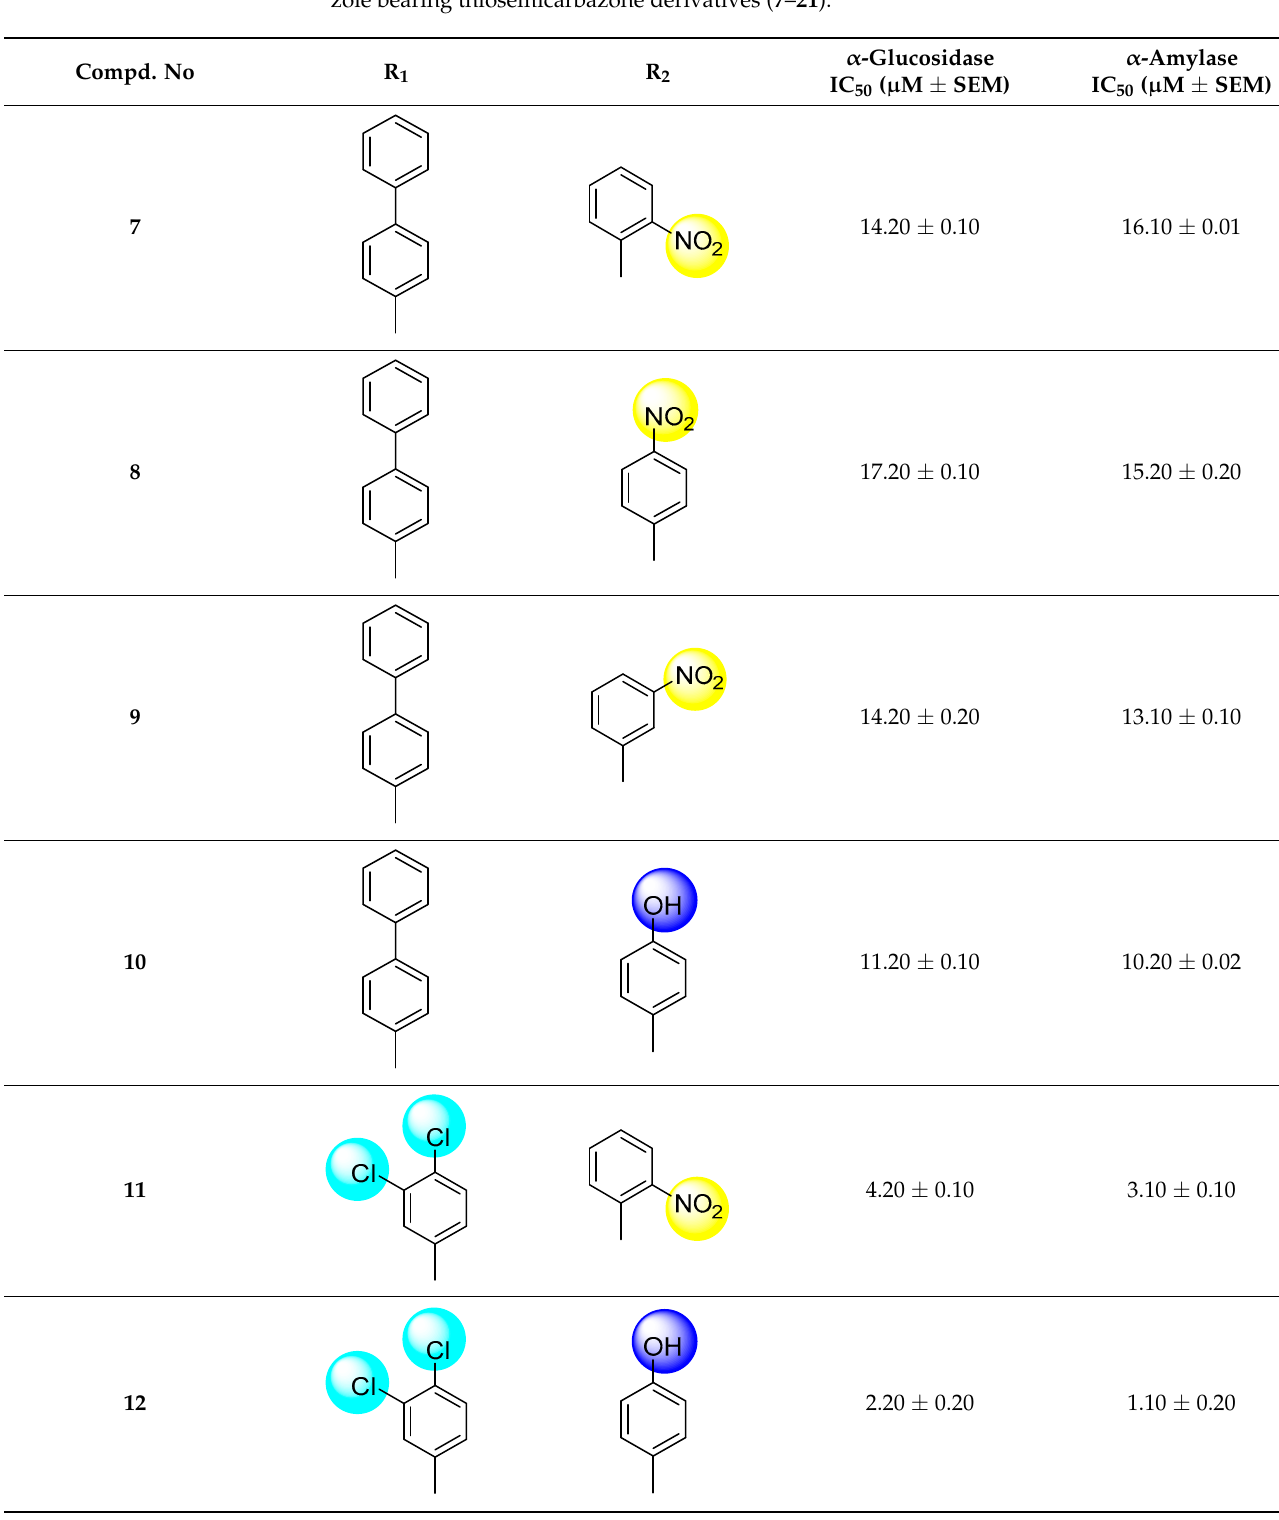
Table 1. Different substituents and α -glucosidase and α -amylase inhibitory activities of benzimida- zole bearing thiosemicarbazone derivatives ( 7 – 21 ).